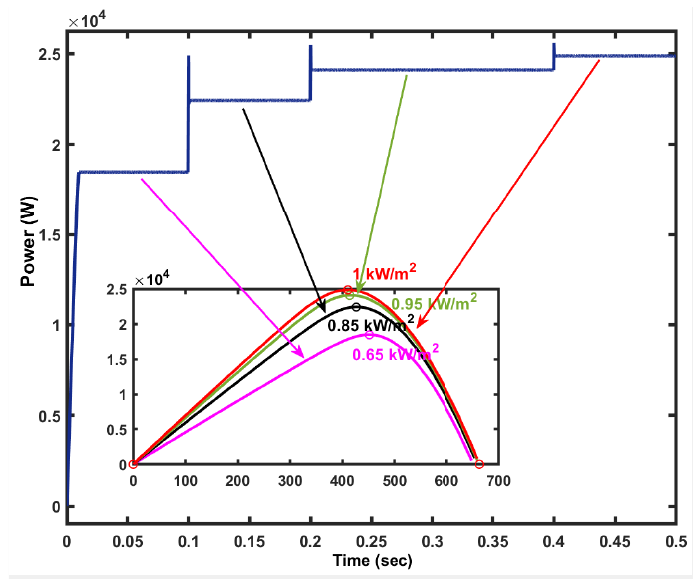
Figure 13. PV output power under varying